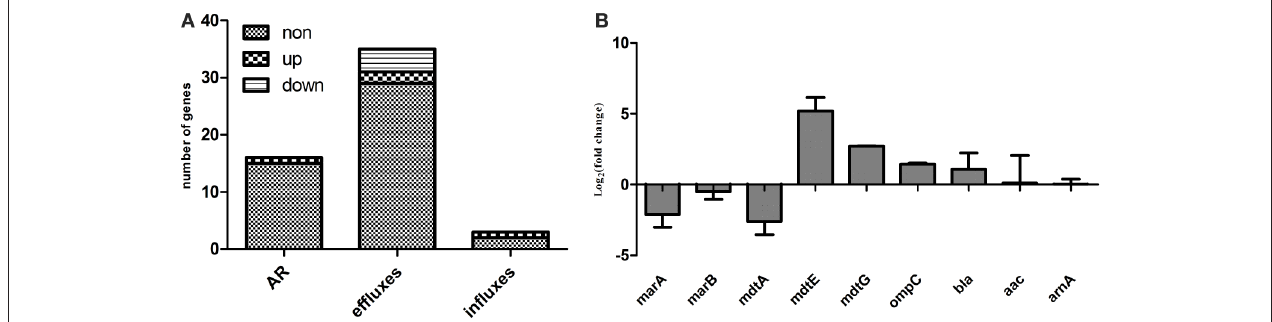
FIGURE 3 | Expression levels of genes involved in antibiotic resistance, antibiotic efflux, or antibiotic influx. (A) Expression levels determined with RNA-seq; (B) qRT–PCR confirmation. AR indicates genes that confer resistance, including beta-lactamase bla , aminoglycoside 3 ′ N-acetyltransferase III ( aac ) etc.; efflux genes include acrAB–tolC , acrDEF , cusCFBA , emrAB , emrKY , mdtABCEF , etc.; and influx genes include ompC , ompF , and phoE, details are available in Table S2 .